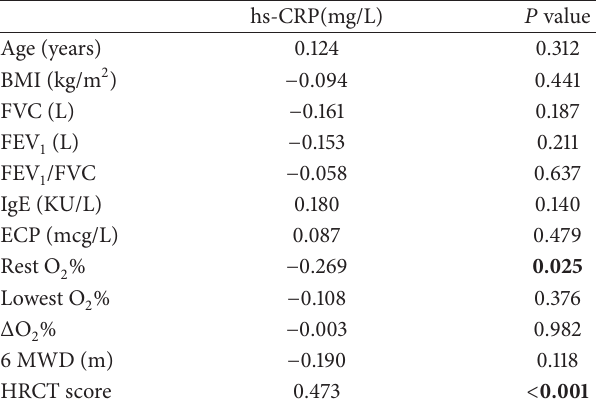
Figure 2: ROC curve of hs-CRP for prediction patients with repeated hospitalization ( ≥ 2 exacerbation-related hospitalization events). Table3:Correlationsbetweenhs-CRP,clinicalvariables,andHRCT score.